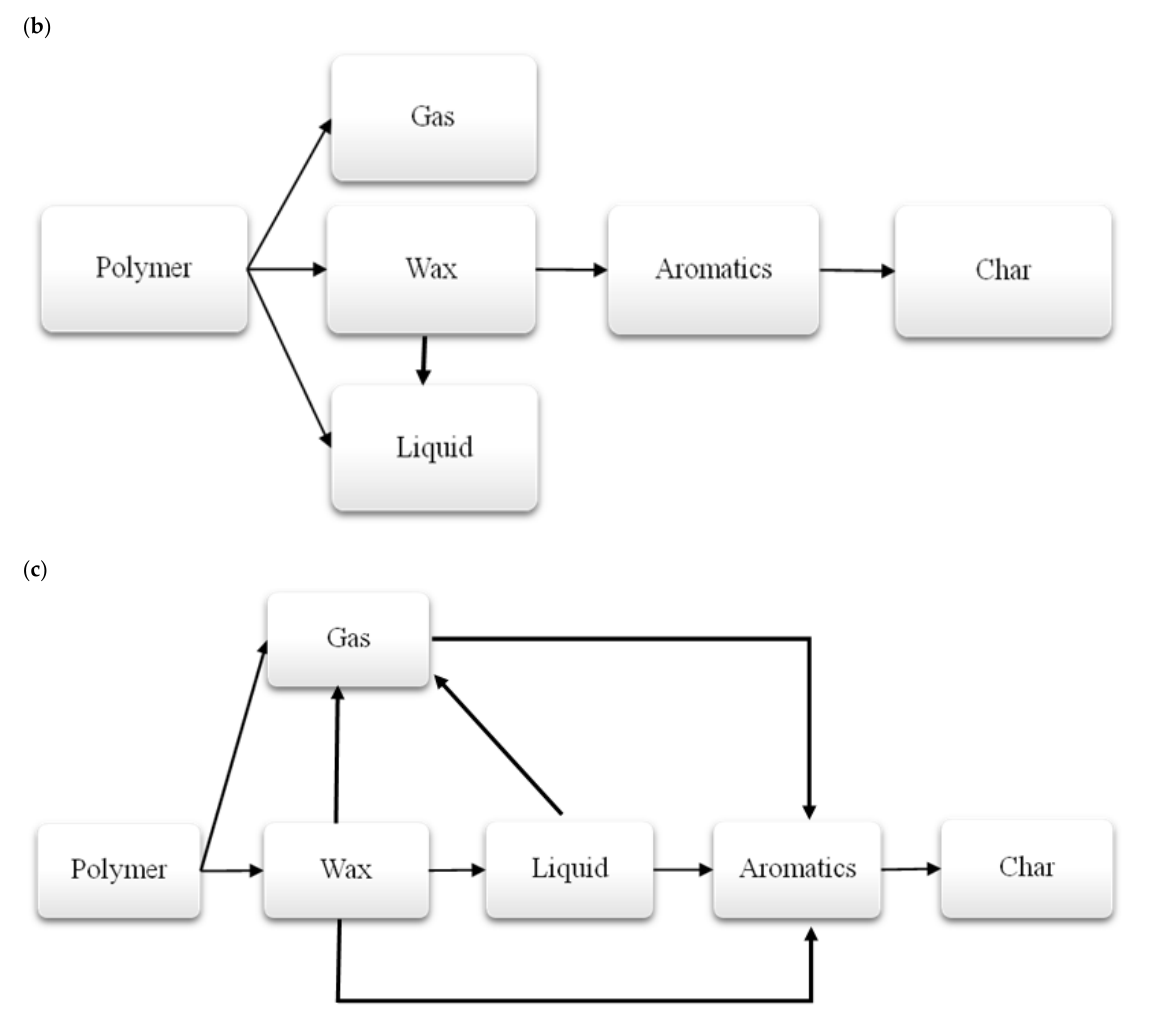
Figure 6. Possible pyrolytic cracking pathways. ( a ) Conversion of low alkenes and alkanes into aromatic compounds. ( b ) Formation of aromatics from waxes. ( c ) Conversion of liquid and gaseous hydrocarbons into aromatic